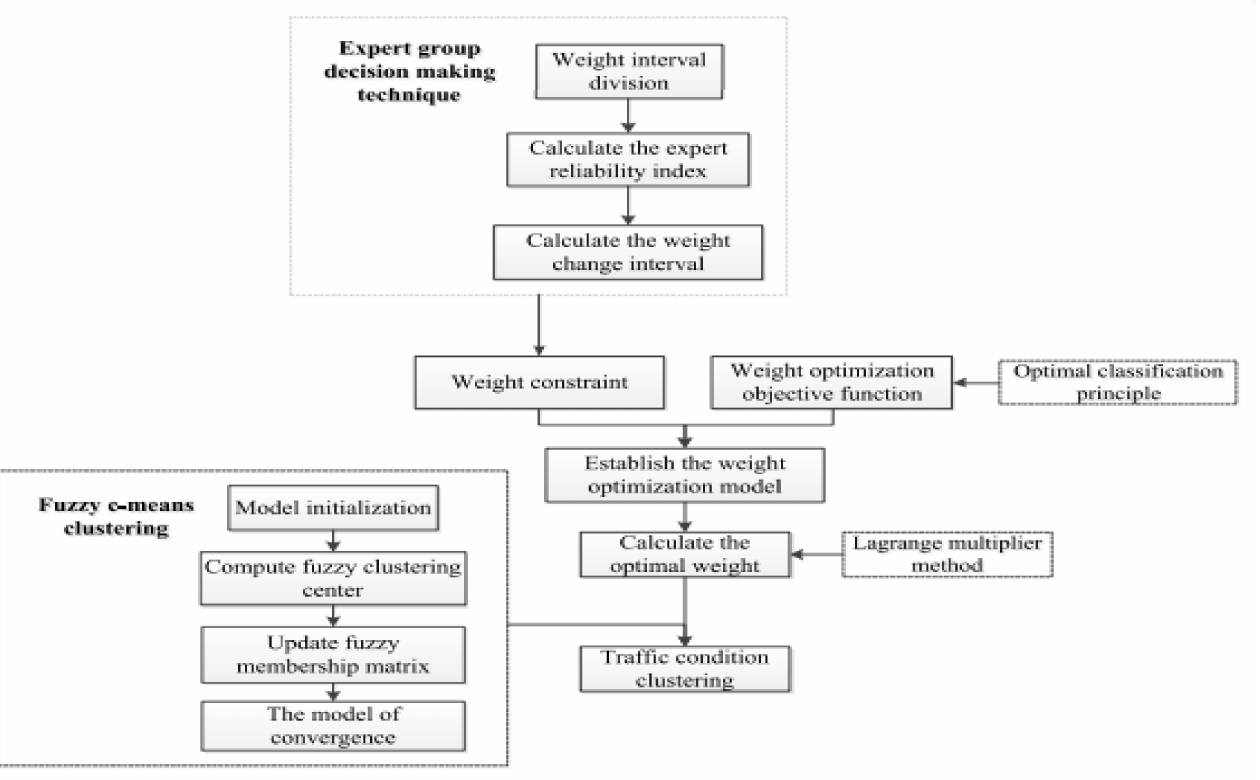
Figure 31. Traffic flow state identification based on multi-parameter fusion clustering